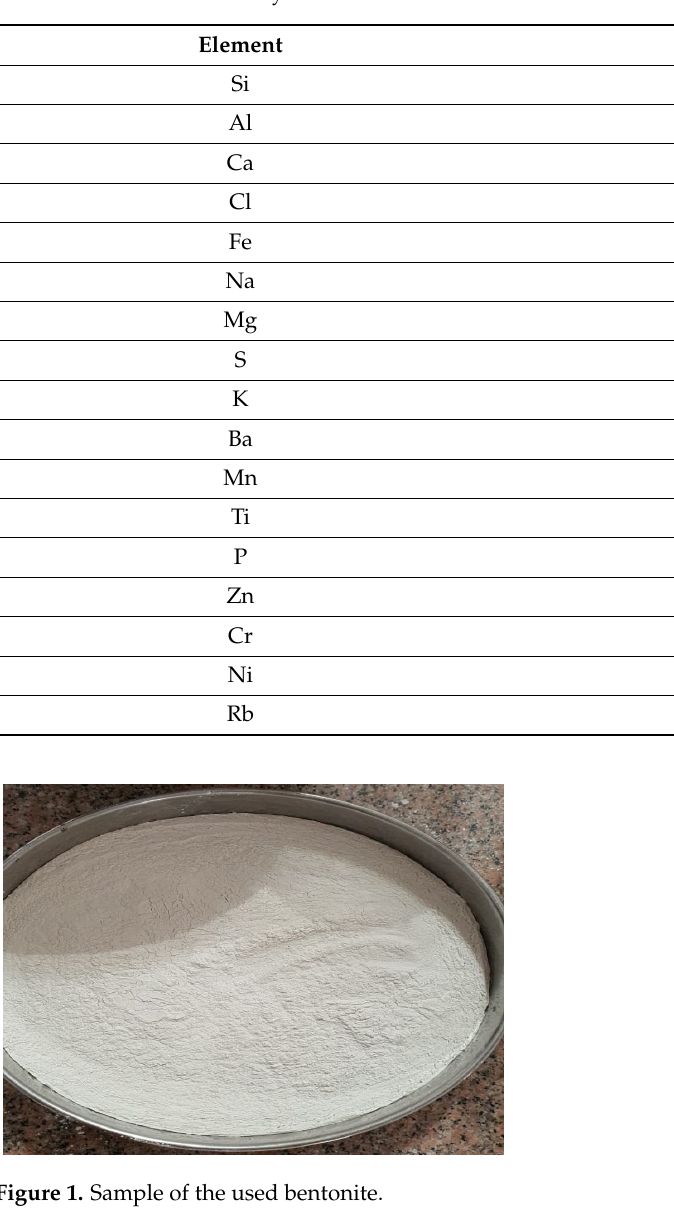
Figure 2. XRD of bentonite clay used in this study. Table 2. XRF elemental analysis of used bentonite. Element